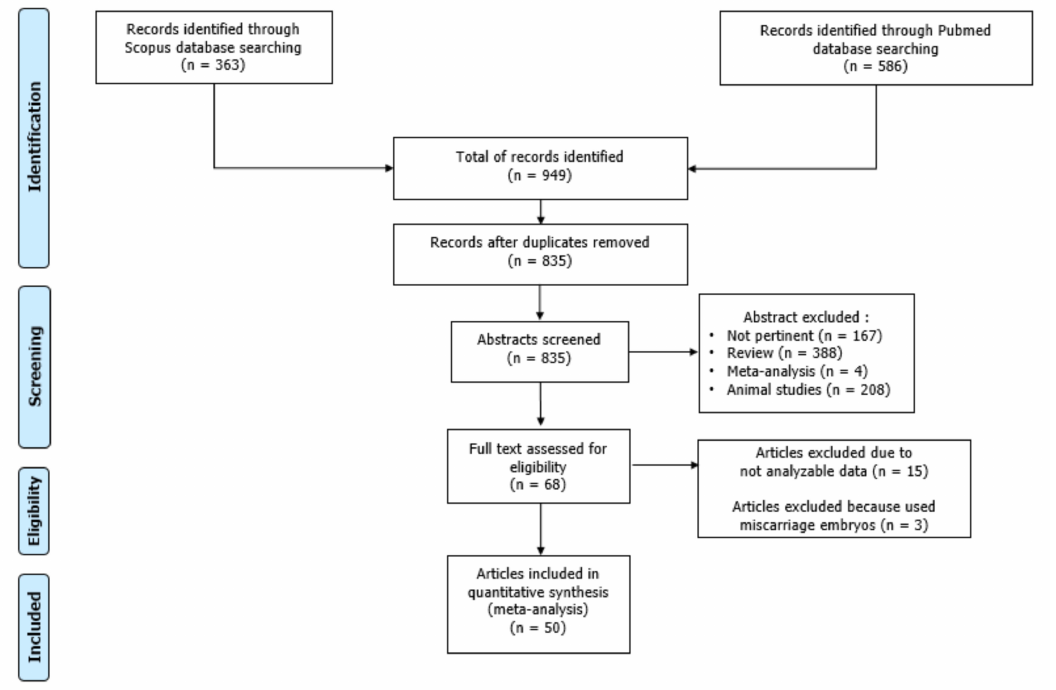
Figure 1. Flowchart of the included